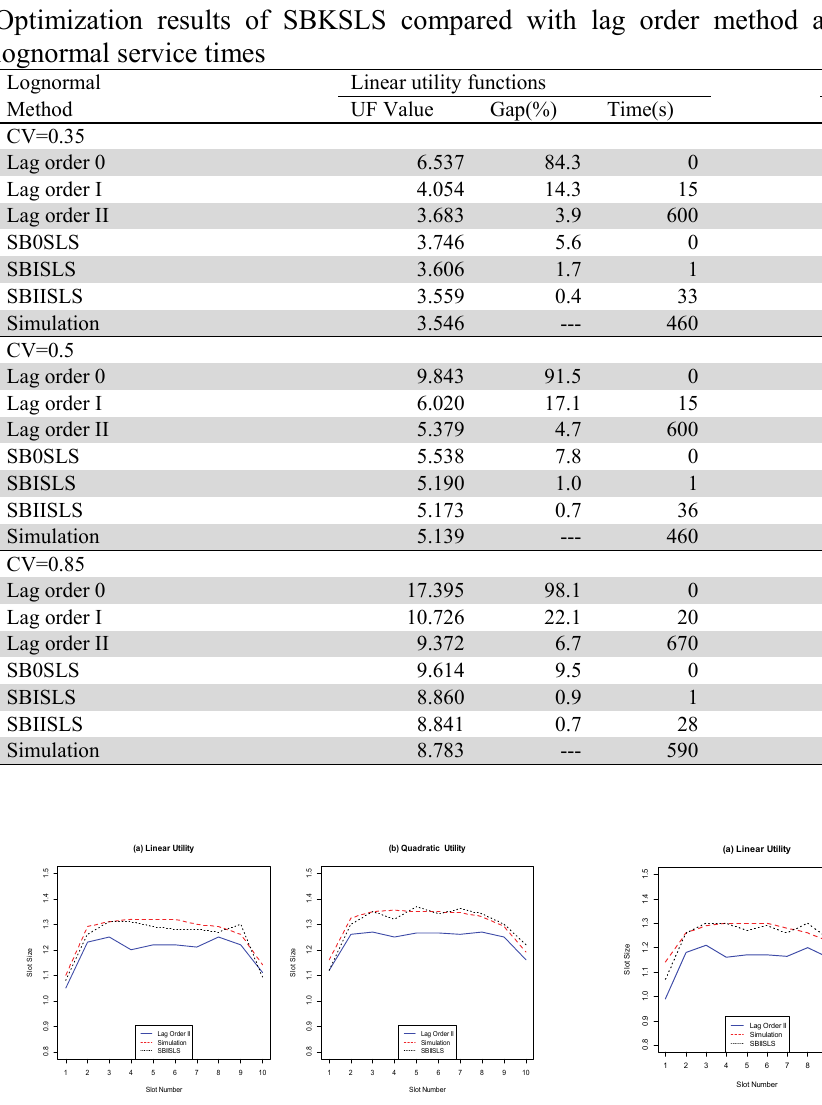
Fig. 4. Optimal lot size for SBKSLS compared with lag order method and simulation. (cid:1840) (cid:3404) 11 , i.i.d. lognormal distributed service times with mean 1 and